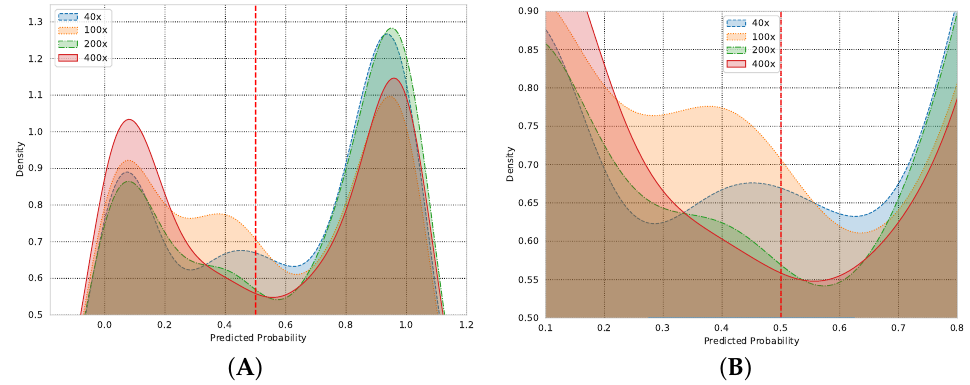
Figure 14. Model’s confusion area for the four magnification factors. ( A ) Confusion area. ( B ) Confusion area zoomed in.